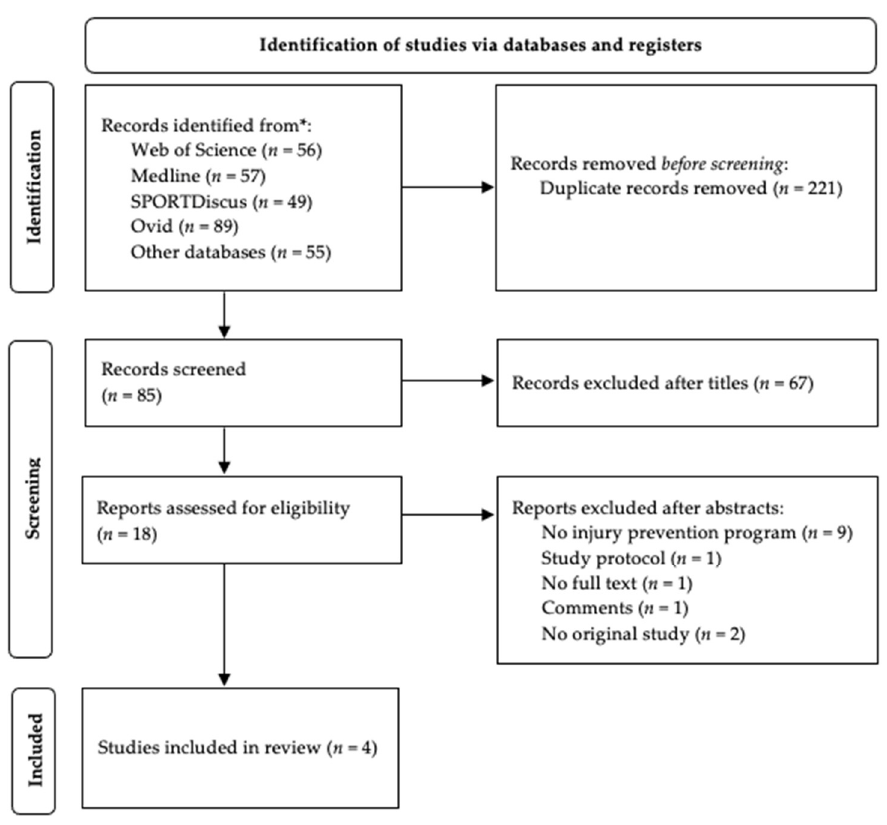
Figure 1. Flow diagram of the number of selected and included studies.